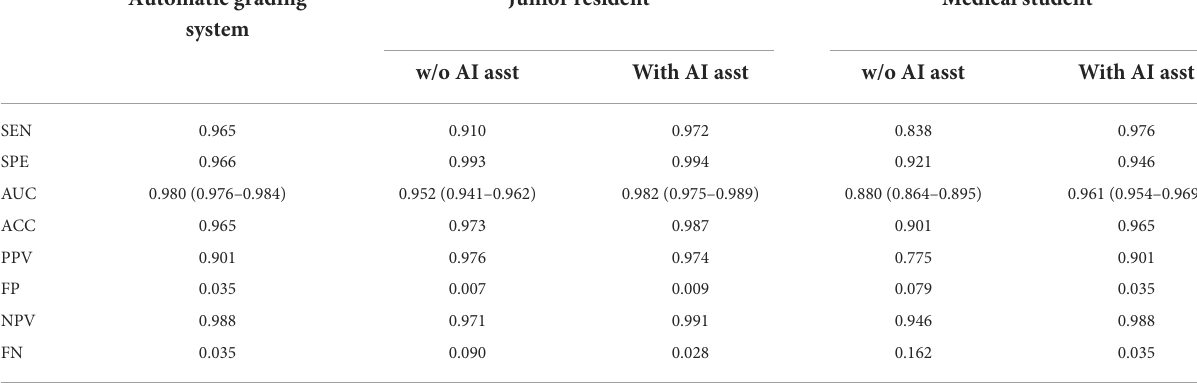
TABLE 3 Two graders with/without artificial intelligence assistance verse automatic grading system on referable diabetic retinopathy